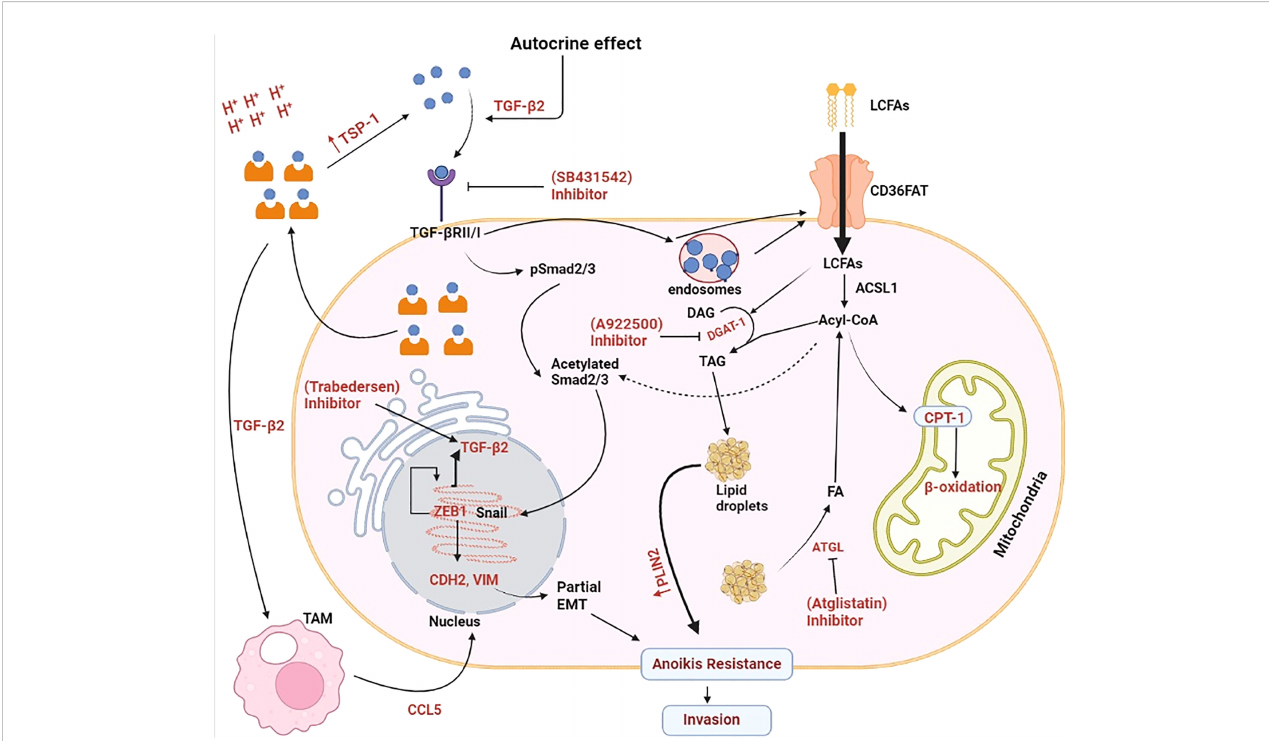
FIGURE 2 Molecular mechanism exploited by lactate for enhancing invasiveness in cancer cells. Lactate-induced acidosis augments epithelial-to-mesenchymal transition in solid tumours. Lactate in the tumor microenvironment (TME) enhances the synthesis and secretion of tumour growth factor- b 2 (TGF- b 2) which acts on tumour cells via an autocrine mechanism and phosphorylates pSmad2/3. After acetylation, pSmad2/3 activates Snail which enters the nucleus and enhances gene expression of N-Cadherin ’ s (CDH2) and Vimentin (VIM). CDH2 protein enhances tumor cell motility and migration. VIM belongs to type-IIIrd intermediate fi lament proteins that maintains cell integrity and plays important role in cell migration, motility and adhesion and subsequently metastasis. TGF- b 2 mediated overexpression of CAD and VIM proteins induces partial epithelial to mesenchymal transition (EMT) and Anoikis resistance in cancer cells and fi nally its transformation into invasive carcinoma cells. Tumour-associated macrophages (TAM) also assist in the EMT process by secreting CCL-5(chemokine cytokine) which further enhances the synthesis and secretion of TGF- b 2. Long chain fatty acid (LCFA) taken from external sources provide Acyl-CoA responsible for the acetylation of pSmad2/3. Excess long chain fatty acids (LCFA) is stored as a lipid droplets (LDs) which ensures continuous supply of Acyl-CoA required for acetylation of Smad2/3 proteins. Increasing demand of energy in the form of ATP during EMT process is ful fi lled by the b -oxidation of fatty acids released from the stored LDs. ACSL1, Acyl-CoA synthetase; ATGL, Adipose triglyceride lipase; CPT1, Carnitine palmitoyltransferase 1; DAG, Diacylglycerol; FA, Fatty acids; PLIN2, Perilipin 2; TAG:,Triacylglycerol; TSP-1, Thrombospondin-1. Created by